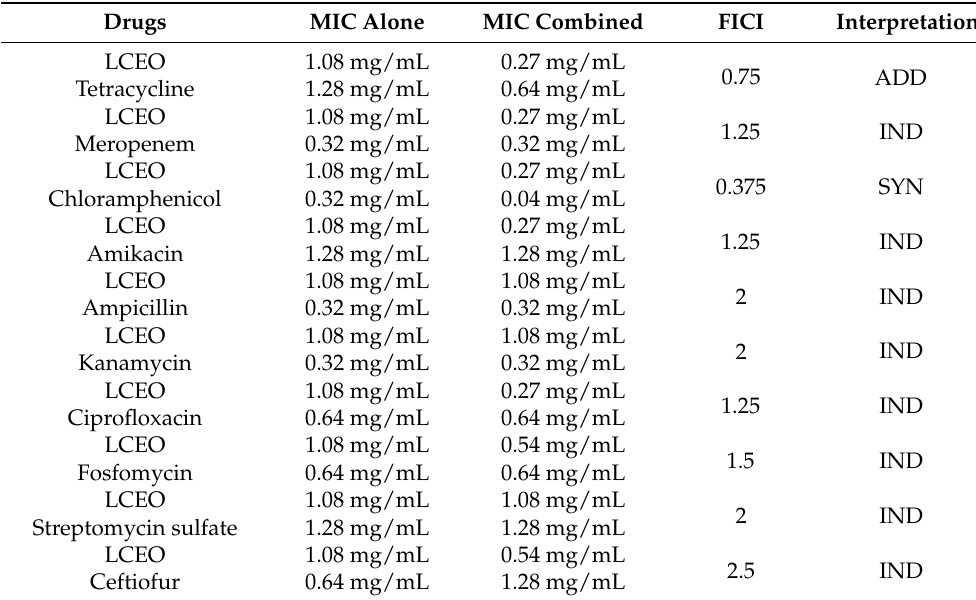
Table 4. Fractional Inhibitory Concentration Index (FICI) values of LCEO with some antibiotics on